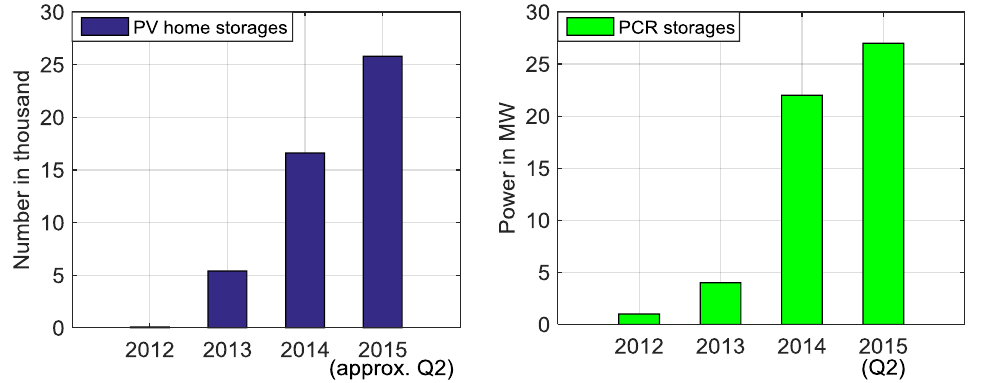
Figure 1. Growth of photovoltaic (PV) and primary control reserve (PCR) storage system markets in Germany [6].